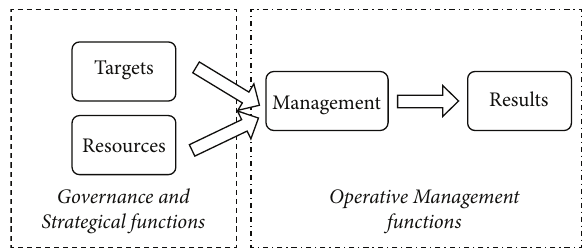
Figure 2. Elements of system performance and corresponding network